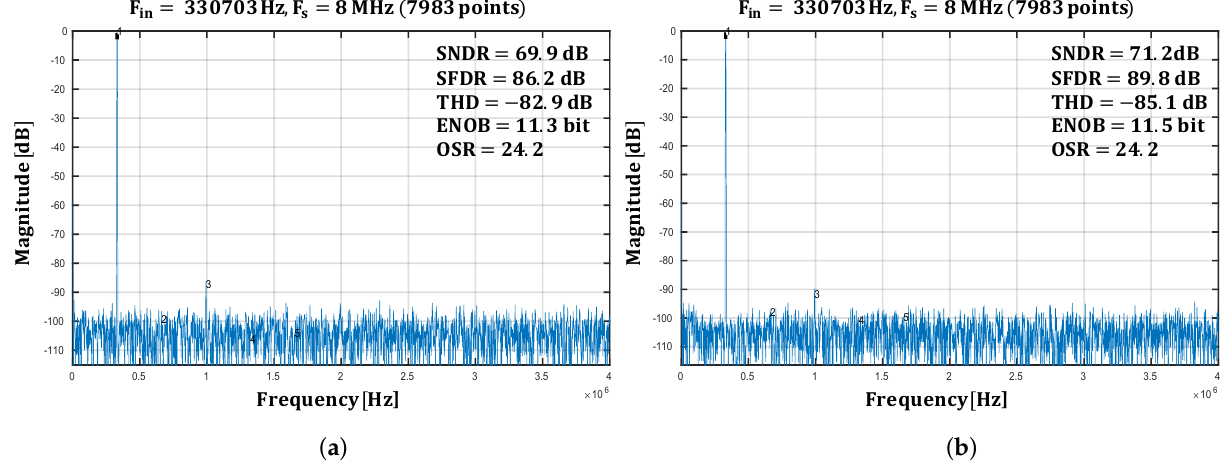
Figure 15. FFT plot with transient noise ( a ) using non-tapered method and ( b ) using proposed method when R ref is 400 Ω at 12-bit 8 MS/s SAR ADC.